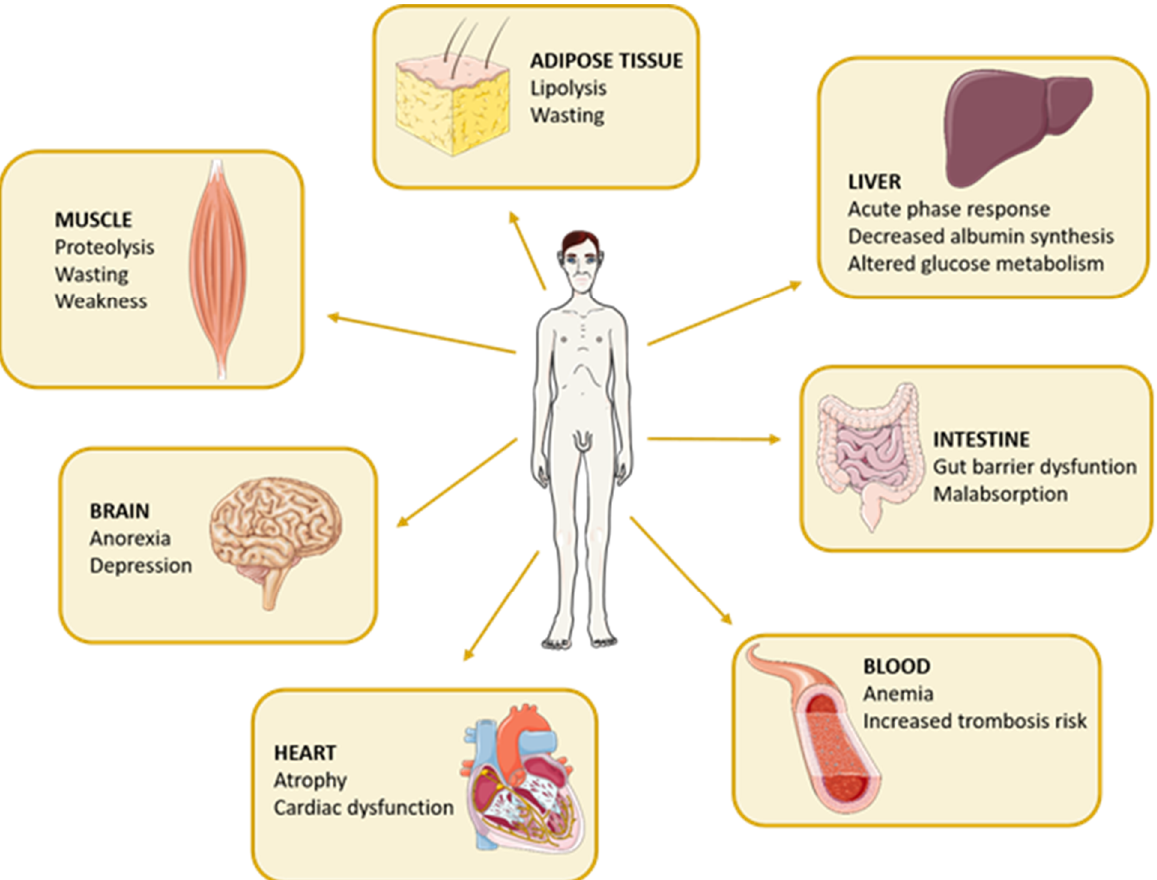
Figure 1. Multi-organ involvement in cancer cachexia. Apart from the wasting of muscle and adipose tissues, cancer cachexia causes functional alterations in many other organs such as in the liver, intestine, blood circulation, heart, and brain.